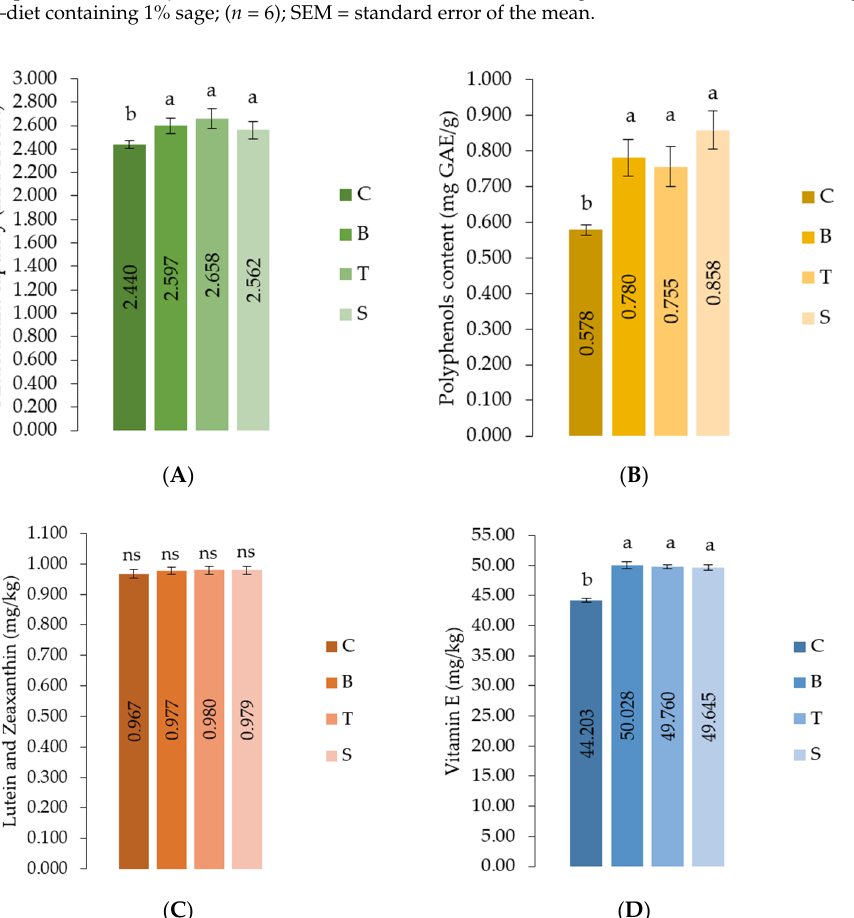
a,b Means in the same row with different superscript letters are significantly different by Tukey's multiple comparison method ( p < 0.05). C—control diet; B—a diet containing 1% basil; T—a diet containing 1% thyme; S—diet containing 1% sage; ( n = 6); SEM = standard error of the mean.